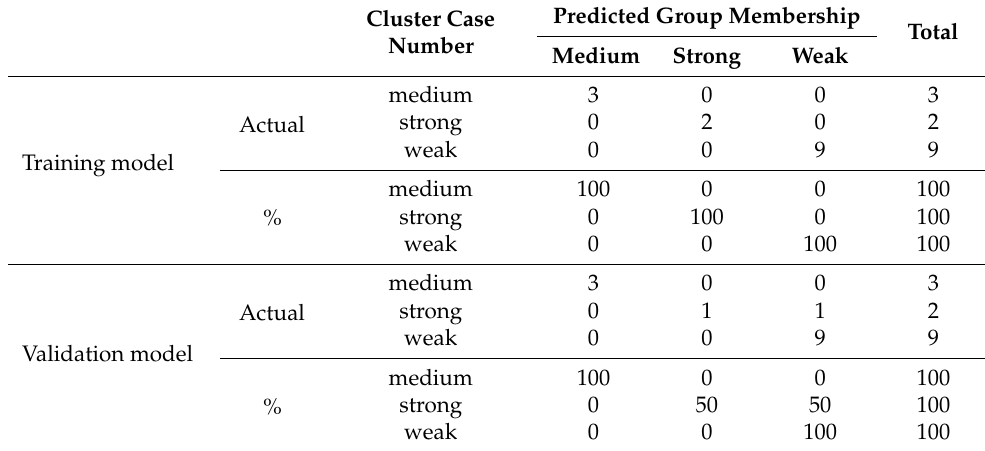
Table 6. Confusion matrix of classification results. In total 13 or 14 samples were correctly classified by the